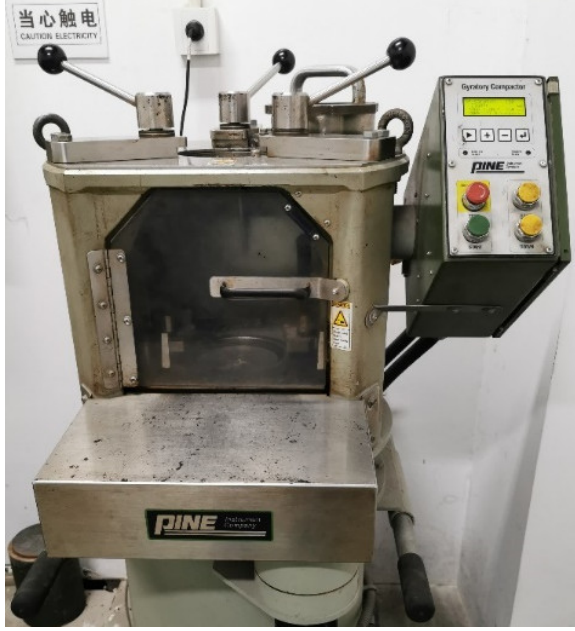
Figure 3. Gyratory compactor.